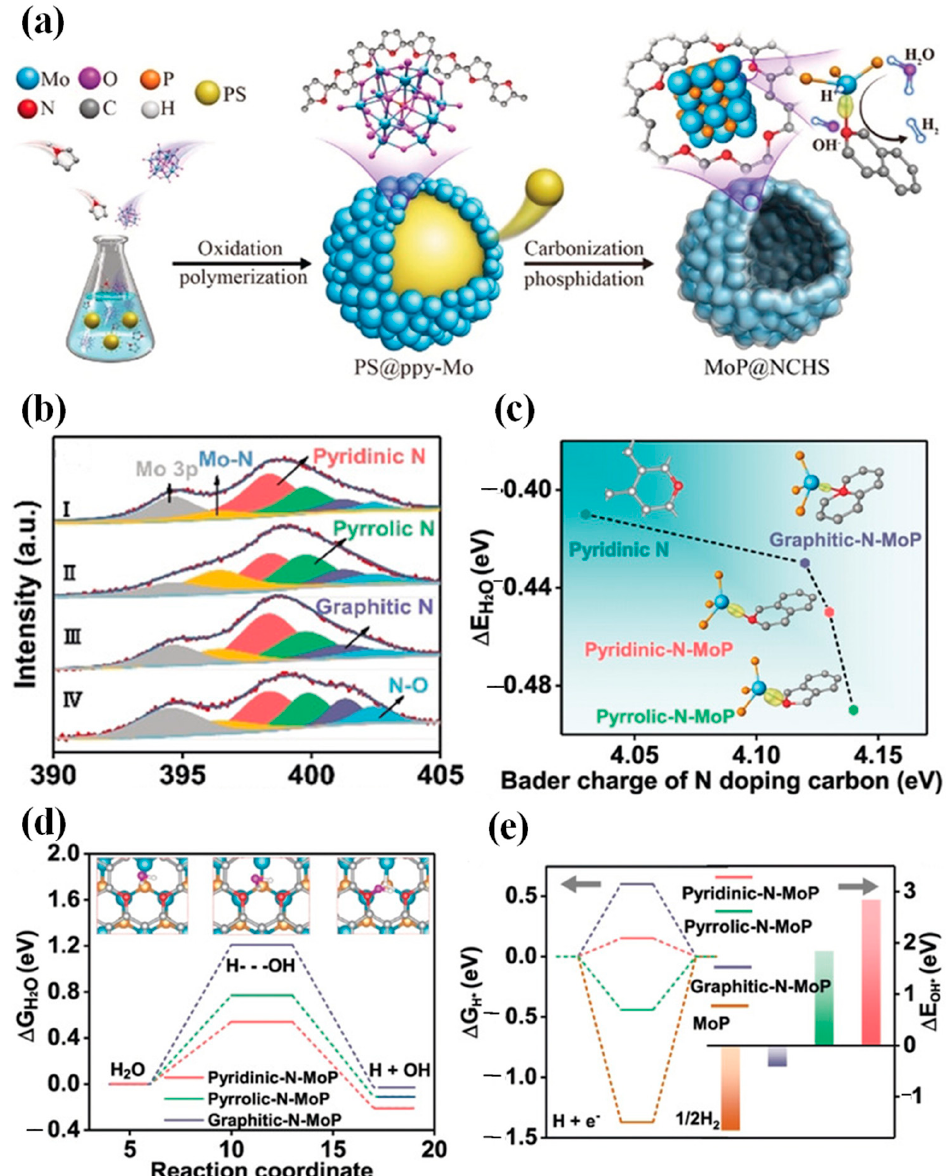
Figure 6. ( a ) Fabrication schematic of MoP@NCHS. ( b ) XPS spectra of N 1s. ( c ) Average Bader charge of N doped carbon. ( d ) Free energy diagram of the water dissociation at pyridinic-N-MoP. ( e ) Chemisorption energies of OH* (right). Reproduced with permission from [68]. Copyright 2020, Wiley.